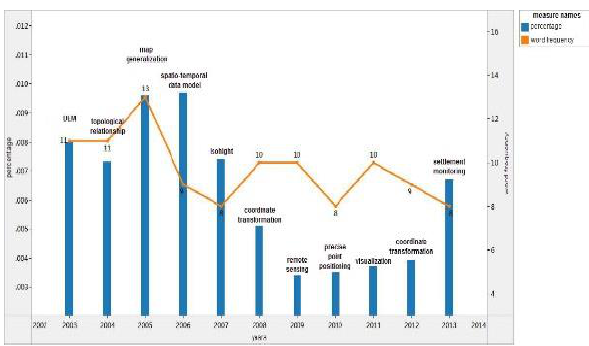
Fig.2 keyword changed by year(from